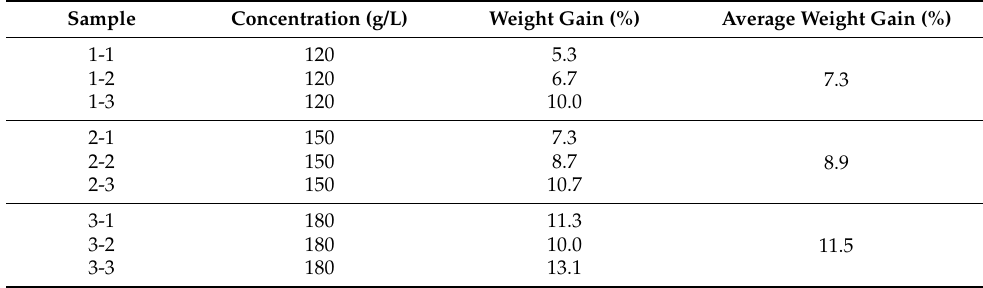
Table 1. Weight gain (WG) of lyocell fabrics treated with 120 g/L, 150 g/L, and 180 g/L finishing